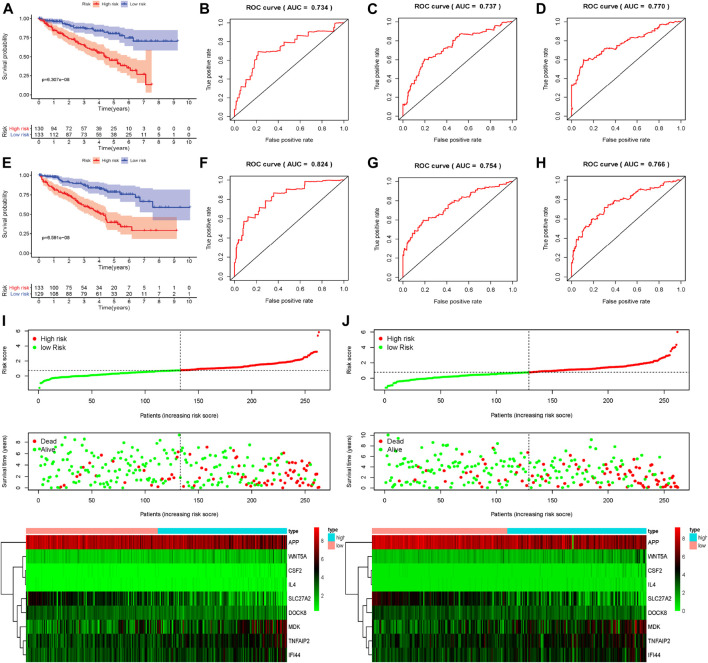
Internal verification of nine apoptosis-related genes signature; (A) Survival curves of OS from high- and low-risk groups of high- and low-risk divided by riskScore in the internal validation dataset 1 (test 1); (B–D) 1-, 3- and 5-year ROC in the internal validation dataset 1 (test 1); (E) Survival curves of OS from high- and low-risk groups of high- and low-risk divided by riskScore in the internal validation dataset 2 (test 2); (F–H) 1-, 3- and 5-year ROC in the internal validation dataset 2 (test 2); (I,J) The distribution of risk scores for samples, the survival status of patients and the expression heatmap of nine differently expressed genes the internal validation dataset 1 (test 1) and in the internal validation dataset 2 (test 2).